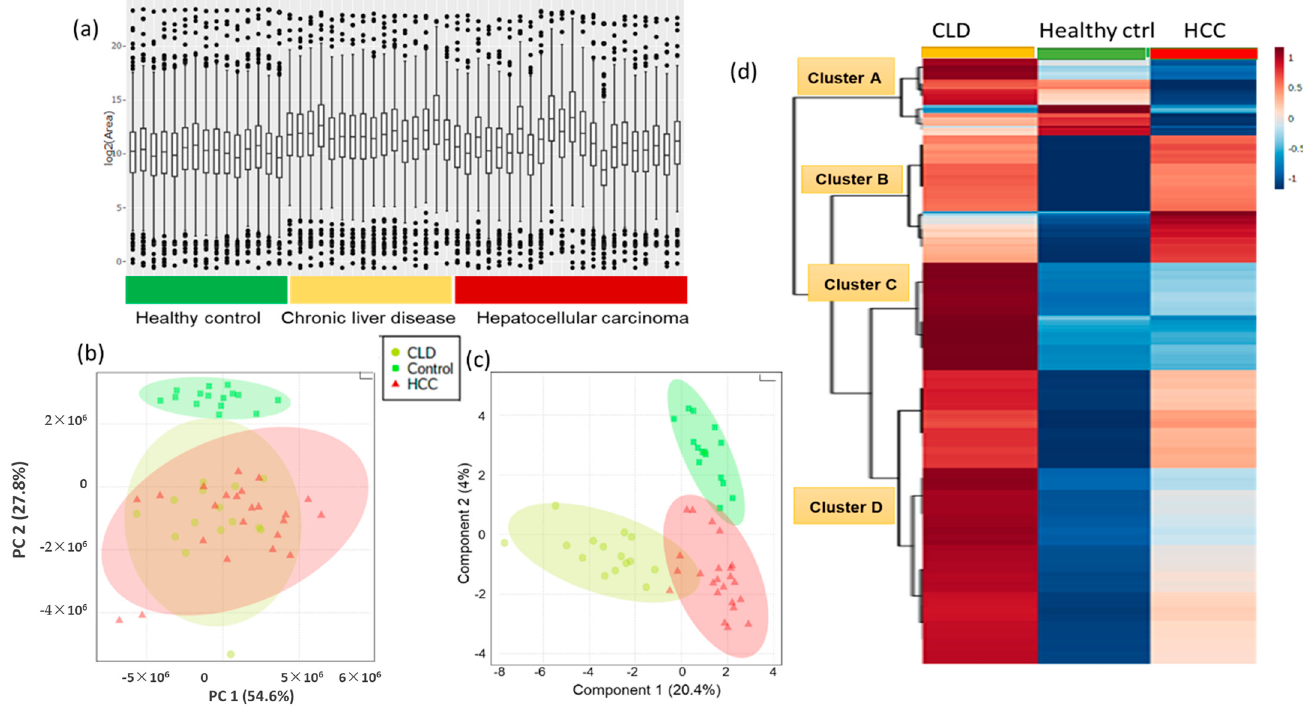
Figure 2. Multivariate and univariate statistical analyses of identified blood lipids in whole in hepatocellular carcinoma (HCC) and chronic liver disease (CLD) patients, and healthy control subjects. ( a ) Distribution of total ion concentrations (TIC) of all lipids for each subject, organized by subject groups. ( b ) Unsupervised principal components analysis (PCA) separating lipid profiles of HCC, CLD and healthy control groups. ( c ) Supervised sparse partial least squares discriminant analysis (sPLSDA) separating lipid profiles of HCC, CLD and healthy control groups. ( d ) Hierarchical clustering heatmap of 524 significant lipids after univariate Kruskal–Wallis tests ( p < 0.05 with qFDR < 0.1). Columns represent lipidomic averages of each subject group. Levels of individual lipid average intensities colored by auto-scaling from high (red) to blue (low) levels.